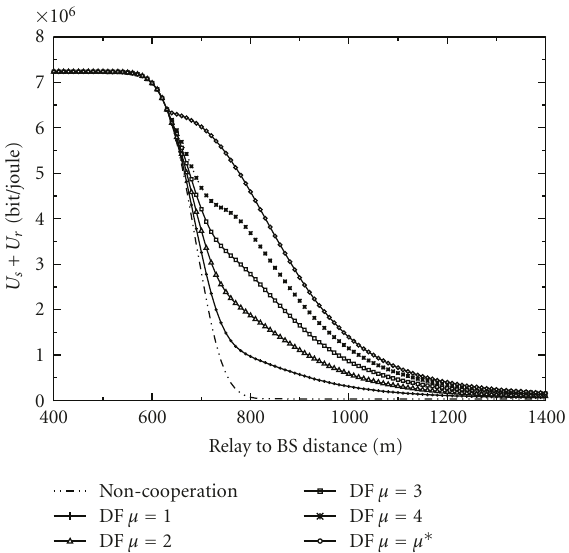
Figure 9: Sum utility of the cooperative system under DF forwarding.